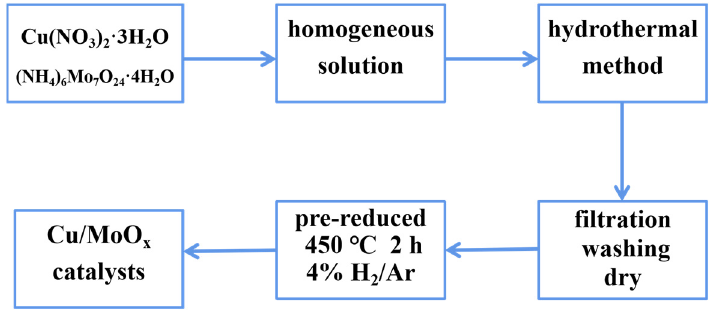
Figure 8. The pattern of Cu/MoO x catalyst preparation